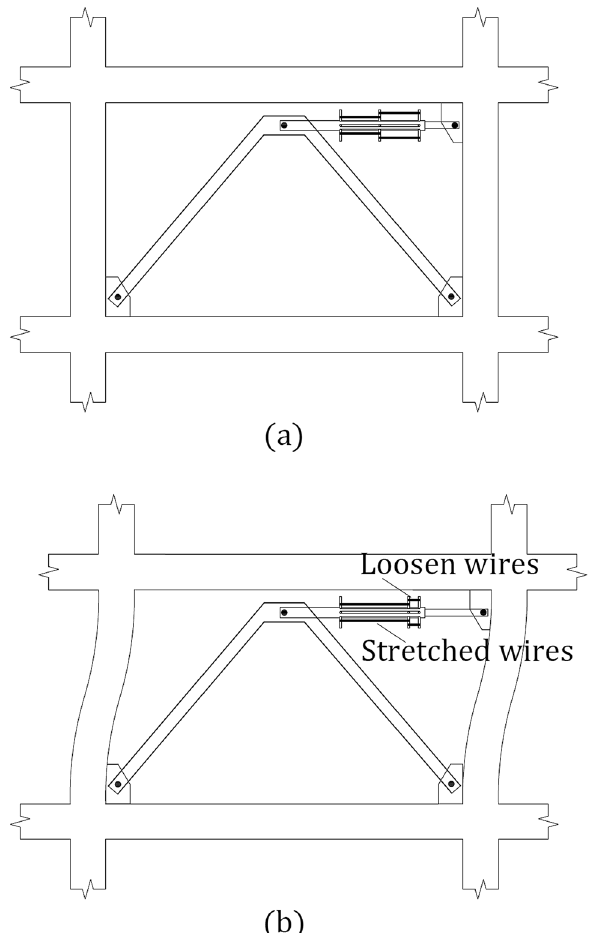
Figure 3. Shape-memory-alloy resisting device ( a ) installation scheme ( b ) under lateral